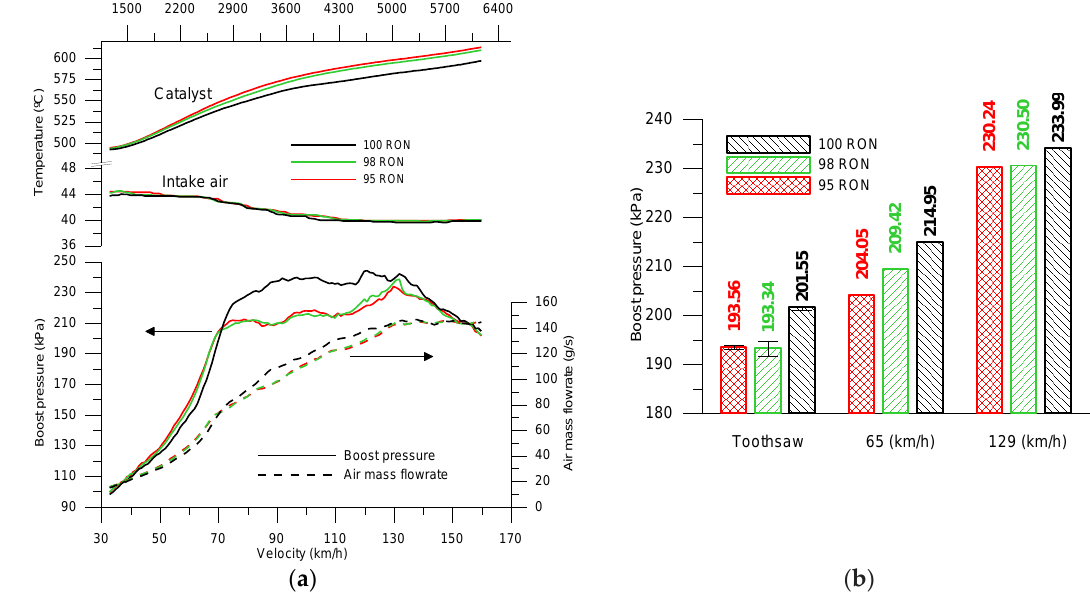
Figure 4. ( a ) absolute boost pressure, air mass flow rate, upstream catalyst temperature and intake air temperature along the toothsaw, ( b ) average absolute boost pressure along toothsaw and steady-state modes.